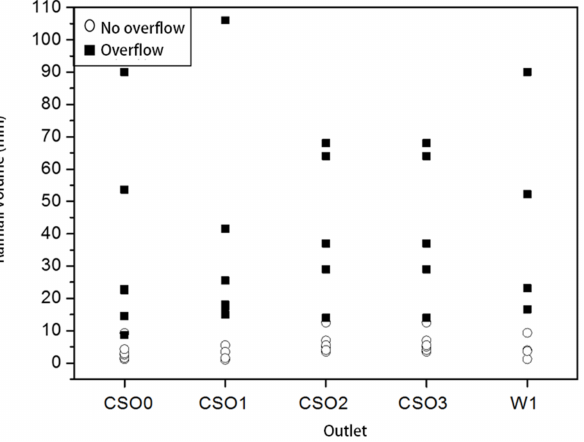
Figure 4. Relationship between rainfall and overflow at each monitoring point.